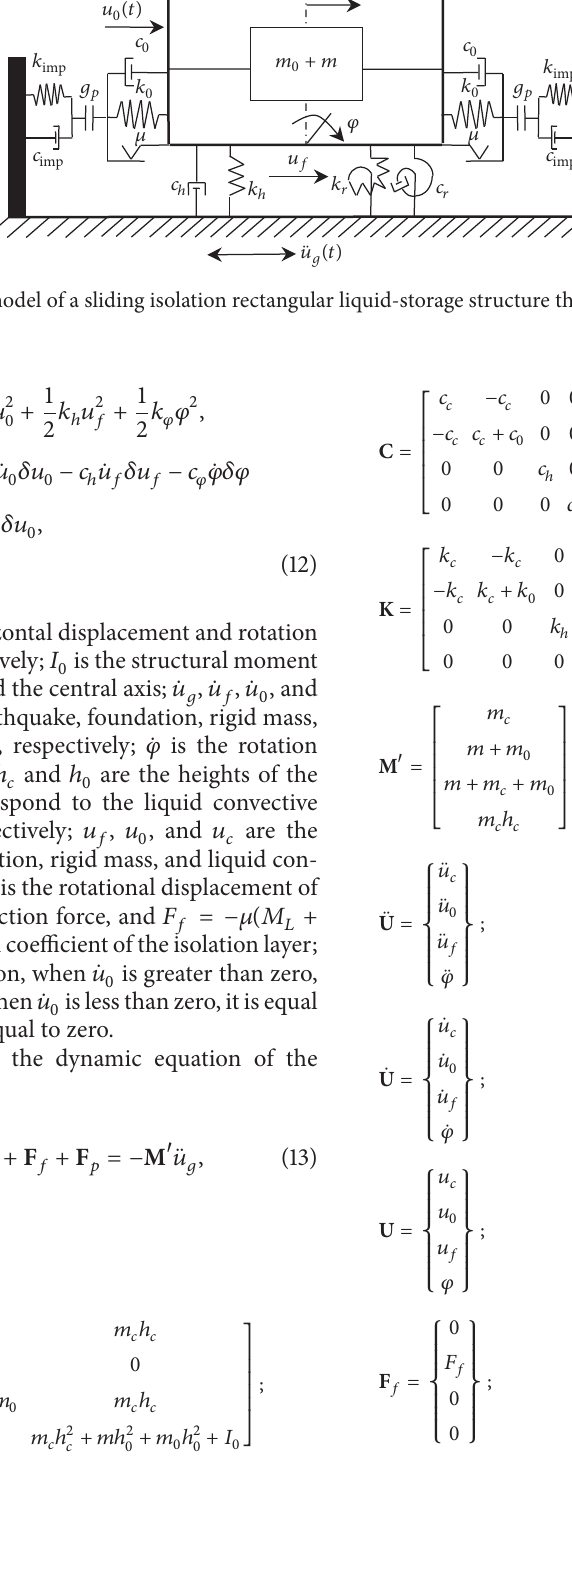
Figure 3: Simplified model of a sliding isolation rectangular liquid-storage structure that considers the SSI and pounding.